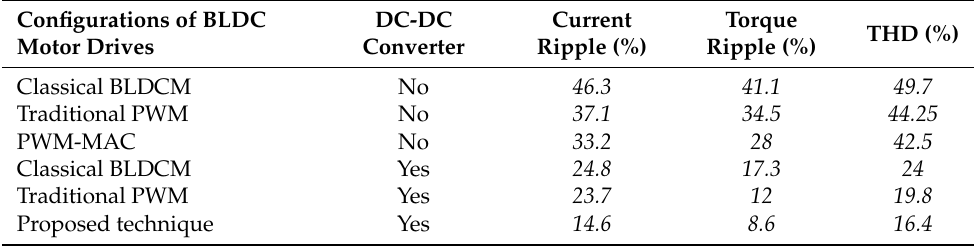
Table 2. Comparative analysis of the BLDCM drives.